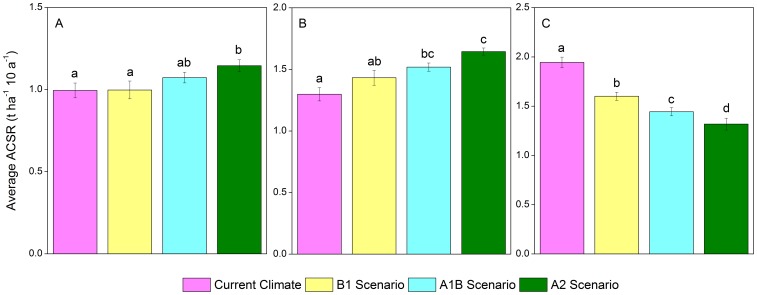
Results of multiple comparisons of the influences on communities’ aboveground carbon sequestration rate.A: Mixed Korean pine hardwood forests in 2060–2100, B: Mixed Korean pine hardwood forests in 2110–2150, and C: Spruce-fir forests in 2160–2200.